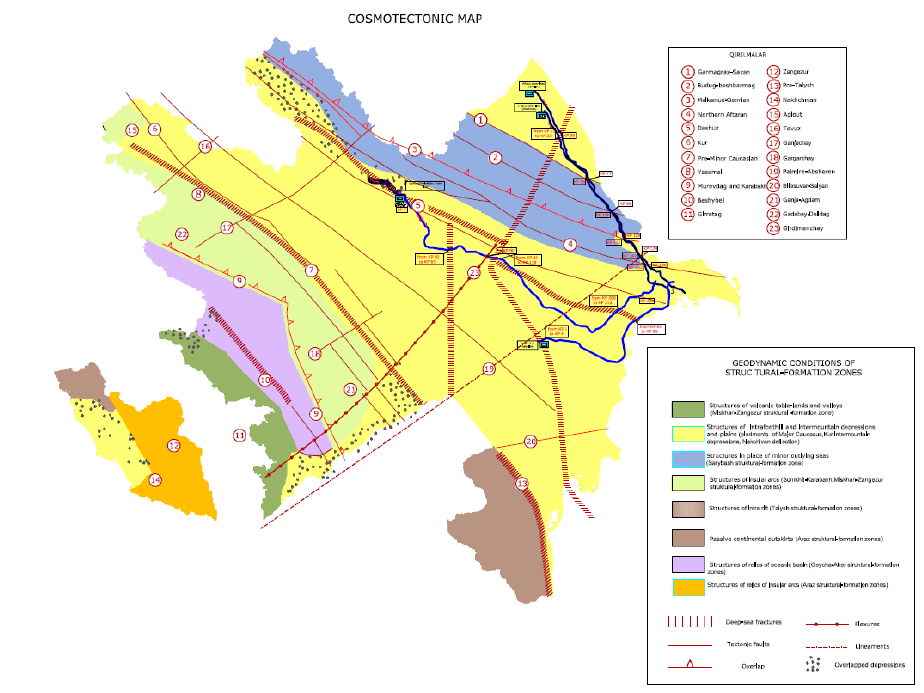
Figure 2. Physical-geographical conditions, geological – geomorphologic structure, seismic-tectonic activity in